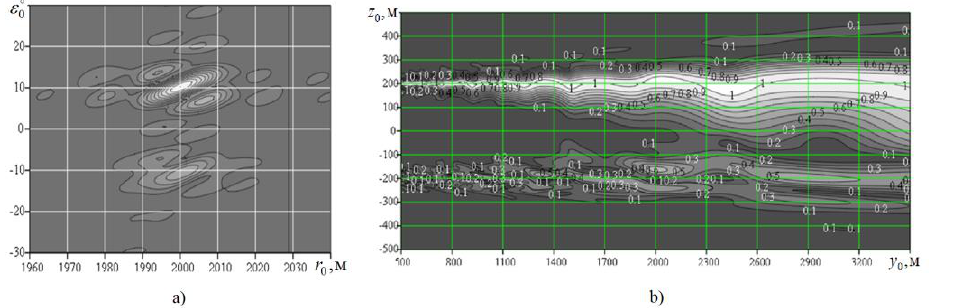
Fig. 3. Two-dimensional cross sections of the normalized module of the generalized correlation ( , ) r  with following conditions: r = 2000 meters, ε = 10°, integral set in: a) polar coordinates 0 0 ( , ) x y with following conditions: β = 0; b) Cartesian coordinates 0 0